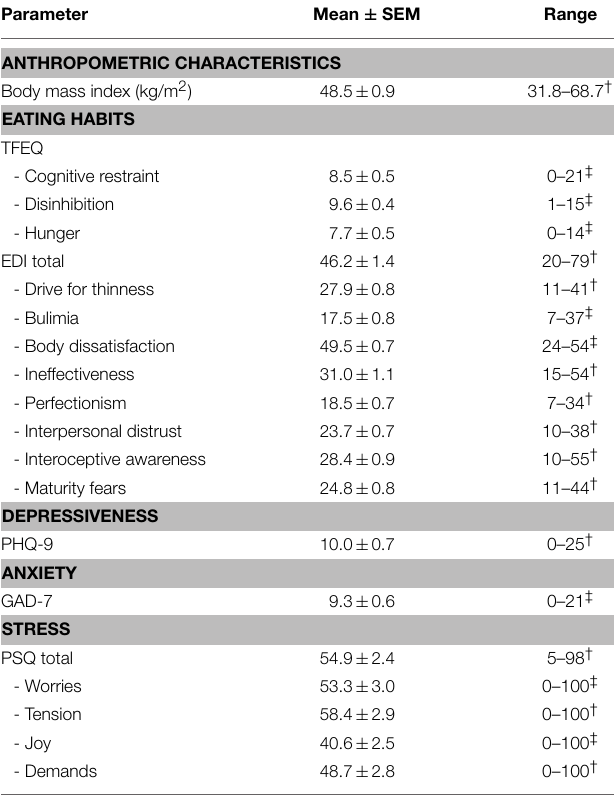
TABLE 5 | Anthropometric and psychometric characteristics in a population of obese patients with broad spectrum of disordered eating and depressiveness.